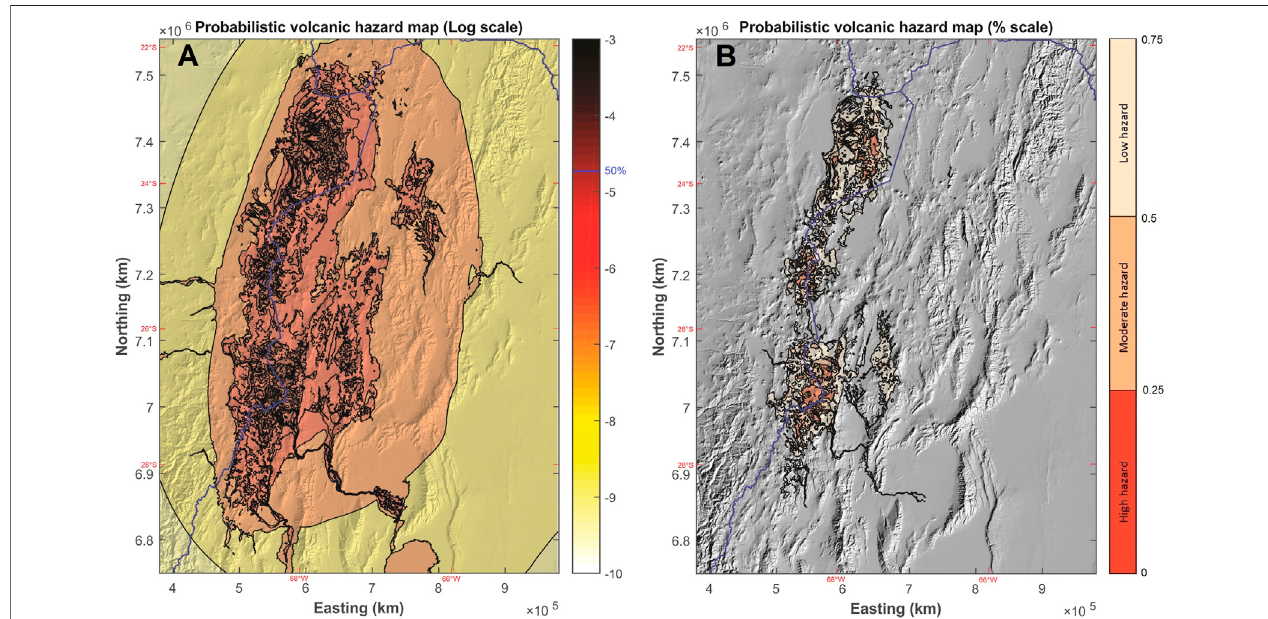
FIGURE 7 | (A) Integrated quantitative volcanic hazard map, constructed by adding each probability map ( Figures 6A – E ), weighted evenly. Legend shows the probability of a 1 km 2 area to be affected by any of the fi ve volcanic phenomena during the next 10 kyr, shown as probability isocontours on a logarithmic scale to illustrate order-of-magnitude changes. Light blue horizontal line drawn in the legend depicts the 50% boundary, which means that if a volcanic phenomenon occurs somewhere, there is a 50% probability it will affect the area enclosed by that boundary. (B) Integrated volcanic hazard map, based on the results obtained in (A) , depicting three cumulative probability intervals: 0% – 25%, 25% – 50%, and 50% – 75%, interpreted as relatively high, moderate, and low hazard regions, respectively. Zoomed-in excerpts highlighting some key regions are provided in Supplementary Figures S10 – S13 . The political border between Chile, Argentina and Bolivia is depicted for reference (blue line). ASTER Digital elevation model used as a background image follows a greyscale colour scheme: the whiter the pixel, the higher the elevation.